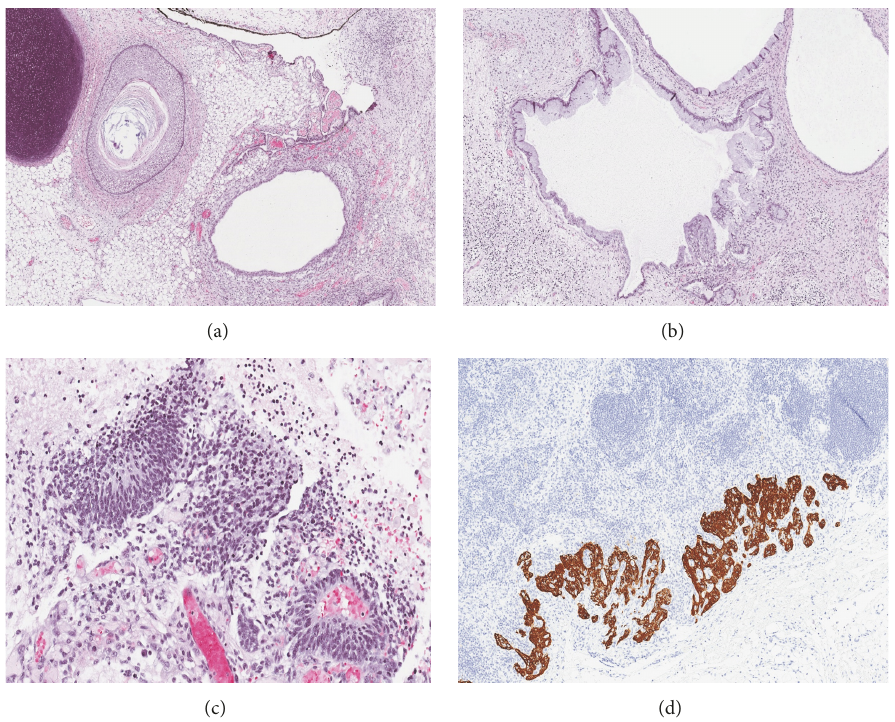
Figure2:Initialovarianteratomawithimmatureelements.(a)Sectionsofimmatureteratomarevealedaneoplasmcomposedofheterogenous elements that included a dermoid cyst, fibroadipose tissue, cartilage, pigmented choroid, and glial tissue (H&E × 100). (b) Cystically dilated glands with enteric differentiation were present (H&E × 100), (c) as well as several foci of immature neuroepithelium (H&E × 200).